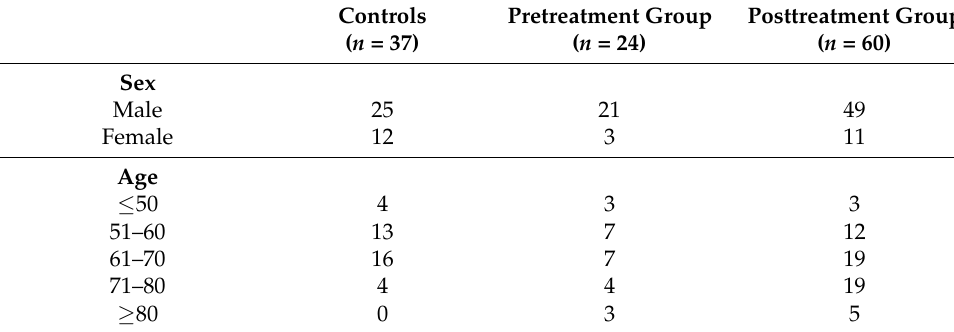
Table 1. Clinical data for HNC patients and